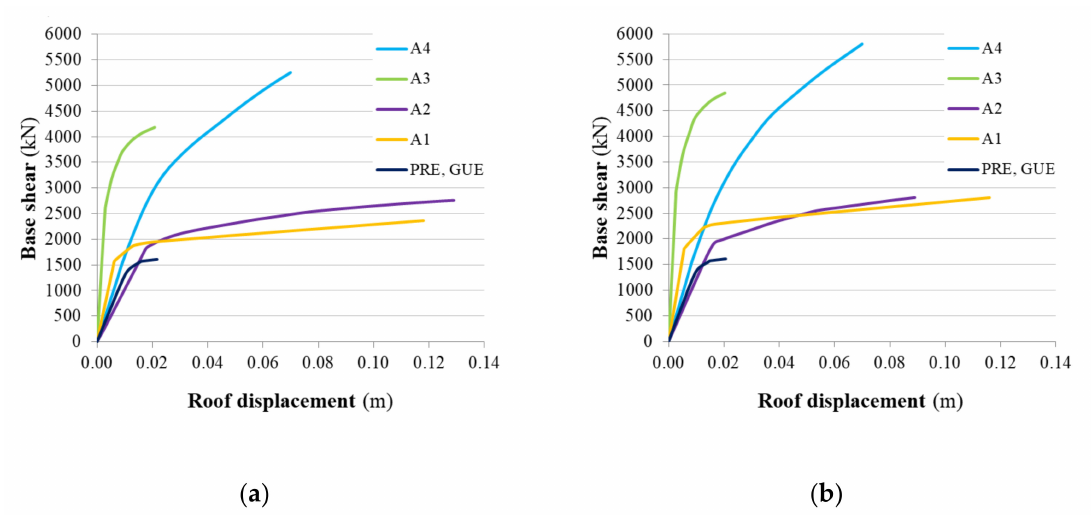
Figure 9. Capacity curves of the examined structures in the longitudinal direction (weak direction) considering the forces distributions proportional to the first vibration mode ( a ) and related to the structural masses ( b